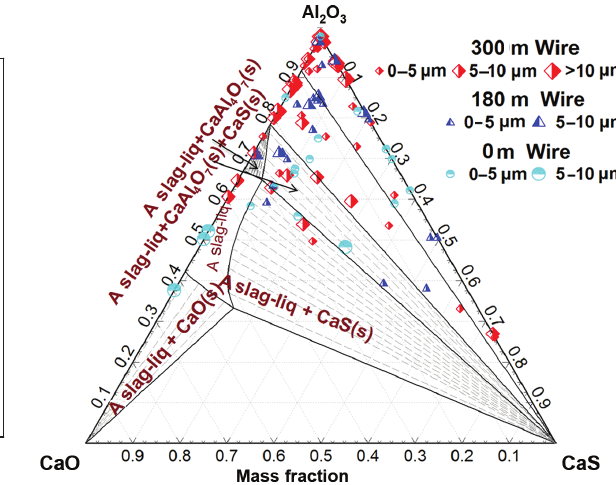
Figure 5: Relationship of inclusion size and its composition.